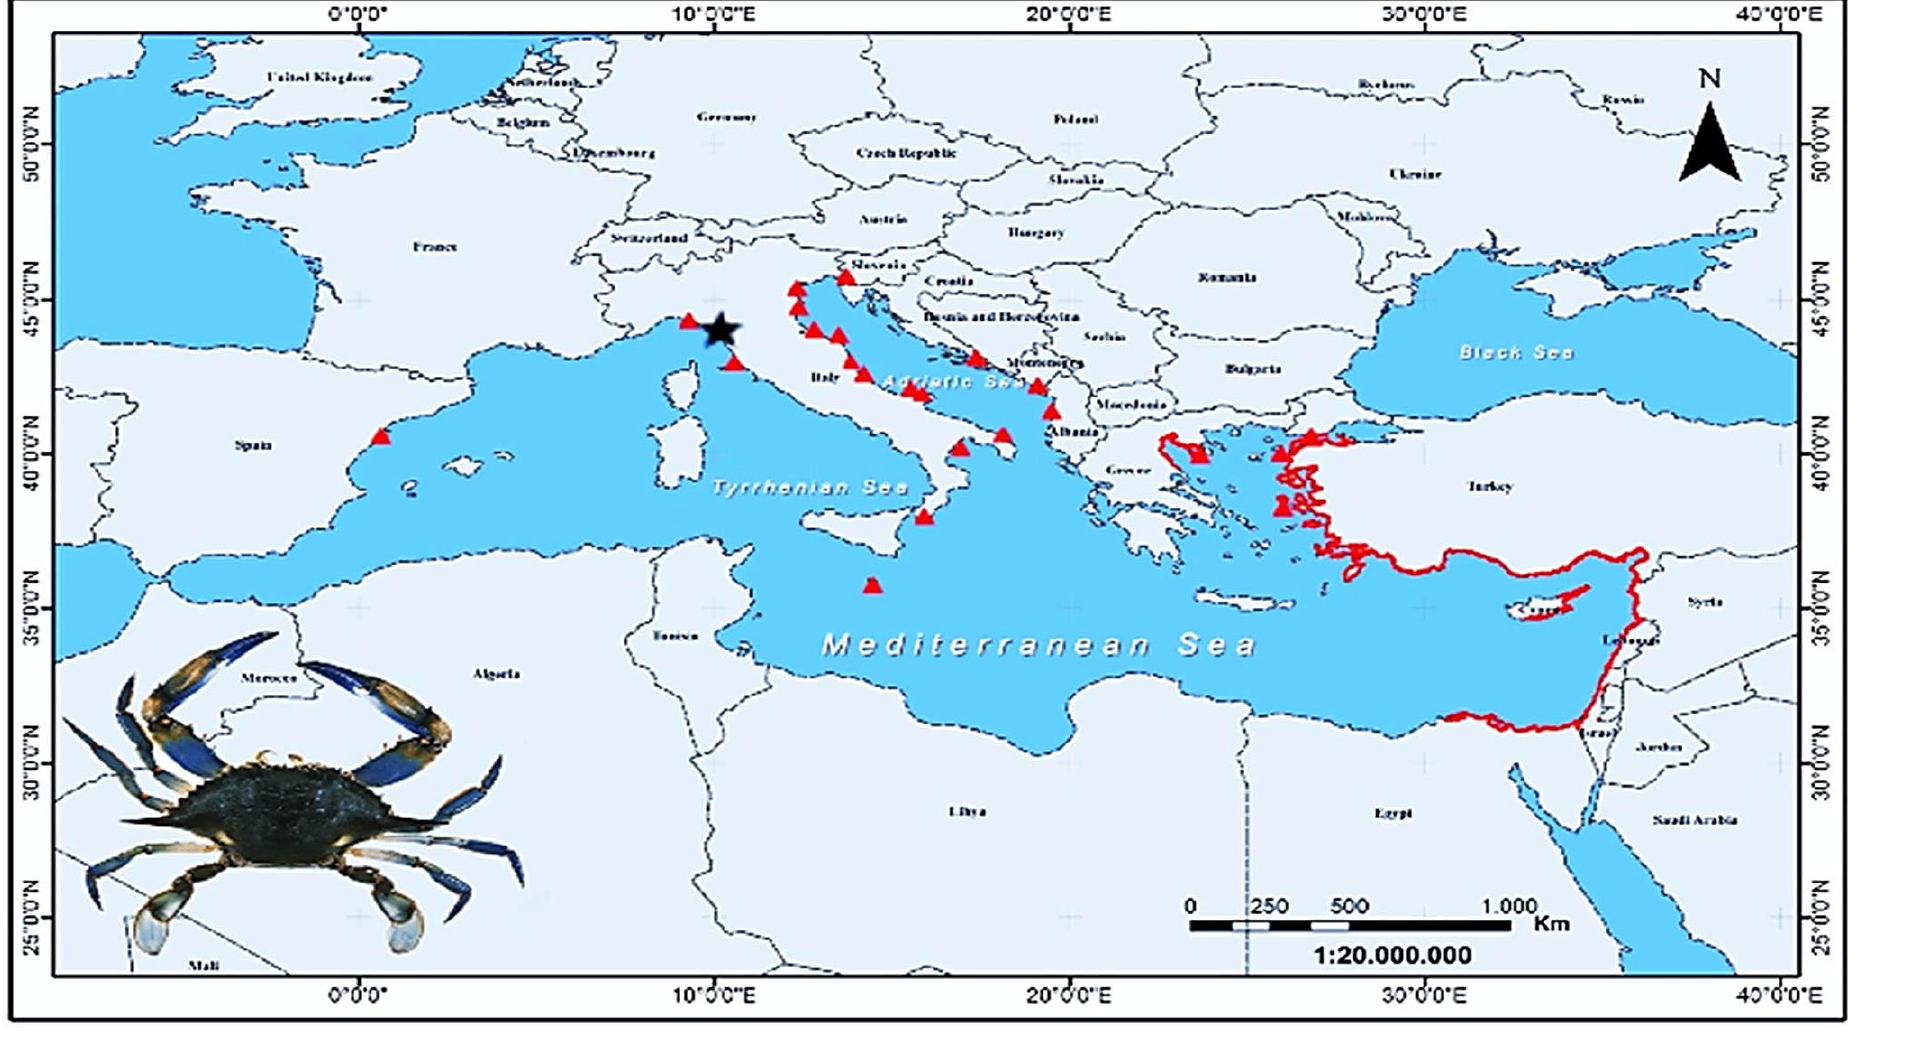
Figure 1. Map of the Mediterranean Sea showing the distribution of the blue crabs ( Callinectes sapidus ) by red dots [7].